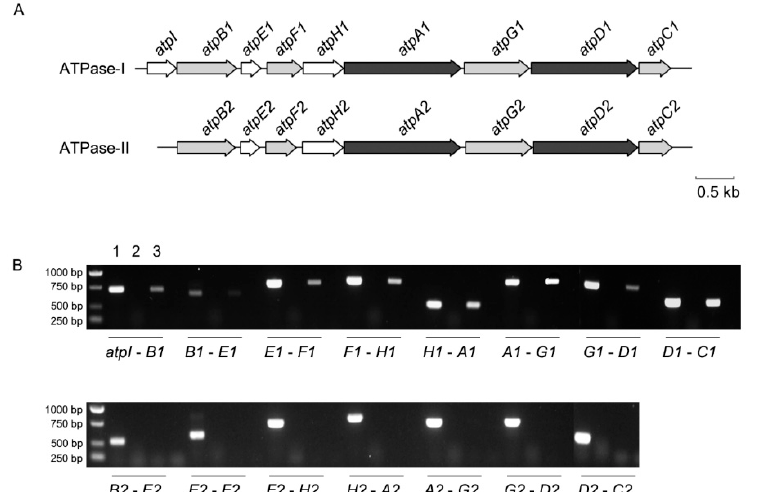
Figure 1. The organization and transcription pattern of two ATPase systems in P. profundum SS9R. Panel ( A ), the organization of two ATPase systems in the genome of strain SS9. The color of the arrows indicates the amino acid sequence identity between orthologs: white arrow indicates no homolog was found in the other set of ATPase or identity below 50%; grey arrow indicates 50–80% identity and black arrow indicates over 80% identity. The arrows are in proportion to the actual length of the genes and a scale bar of 0.5 kb is presented. Panel ( B ), the amplification of the intergenic region in ATPase-I ( top ) and ATPase-II ( bottom ) gene clusters. The 1 to 3 lanes for each intergenic region represent DNA, RNA and cDNA samples, respectively. The text below the image indicates the amplified region, for example atpI - B 1 represent intergenic region between atpI and atpB 1.